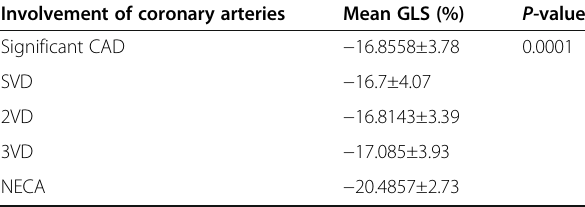
Abbreviations: SVD single vessel disease, 2VD two-vessel disease, 3VD three- vessel disease, NECA normal epicardial coronary